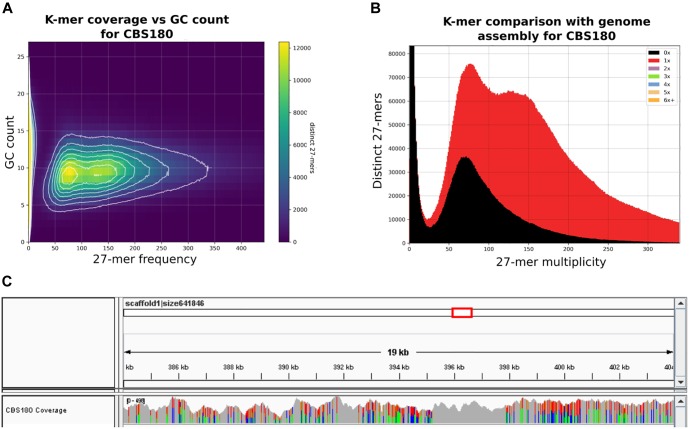
Heterozygosity patterns in Candida inconspicua type strain genome. (A) 27-mer frequency in CBS180 genomic reads and respective GC content. (B) 27-mer frequency in CBS180 genomic reads and indication of their presence (red) or absence (black) in the genome assembly. Although both 27-mer count peaks were represented in the genome assembly, roughly half of the reads corresponding to the first one was excluded. These reads probably correspond to redundant heterozygous contigs that were intentionally removed during the reduction step of the assembly process (see section “Materials and Methods”). (C) IGV coverage track of a 19 kb region of C. inconspicua scaffold 1. Colors represent polymorphic positions. Highly heterozygous regions are clearly interspaced by blocks of loss of heterozygosity (LOH).